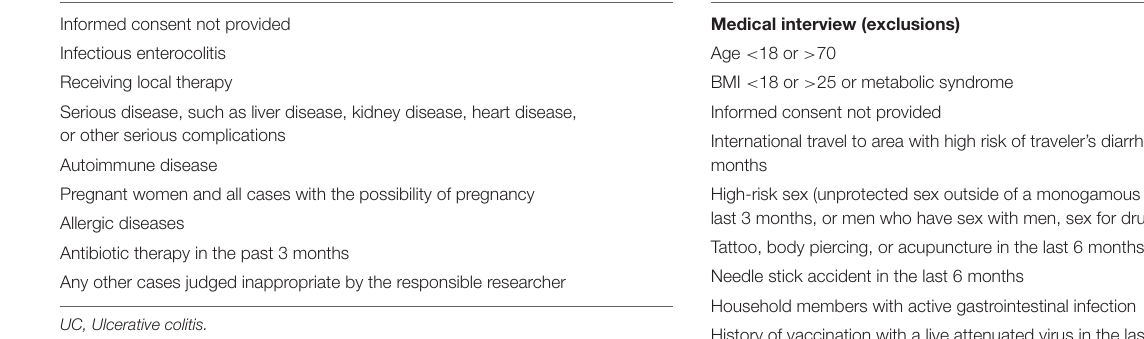
TABLE 2A | Donor exclusion